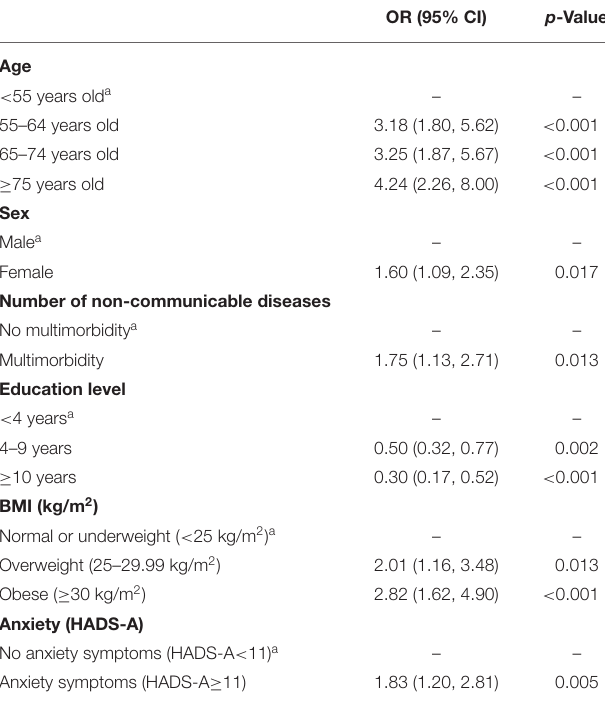
TABLE 4 | Factors associated with clinical severity in the final multivariable ordinal regression model.